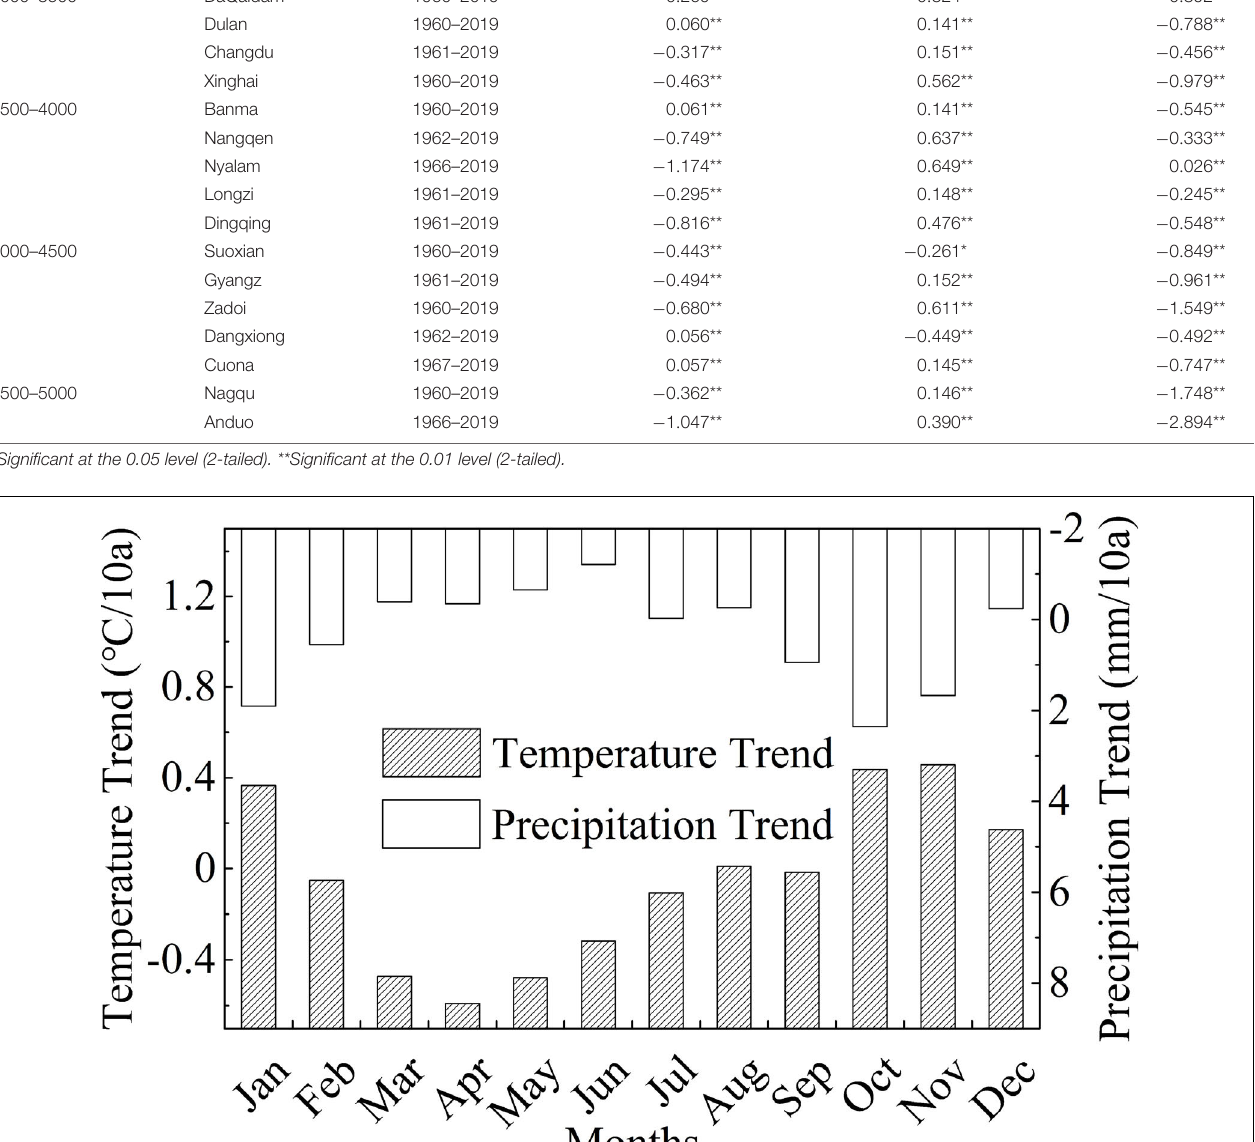
Frontiers in Earth Science |